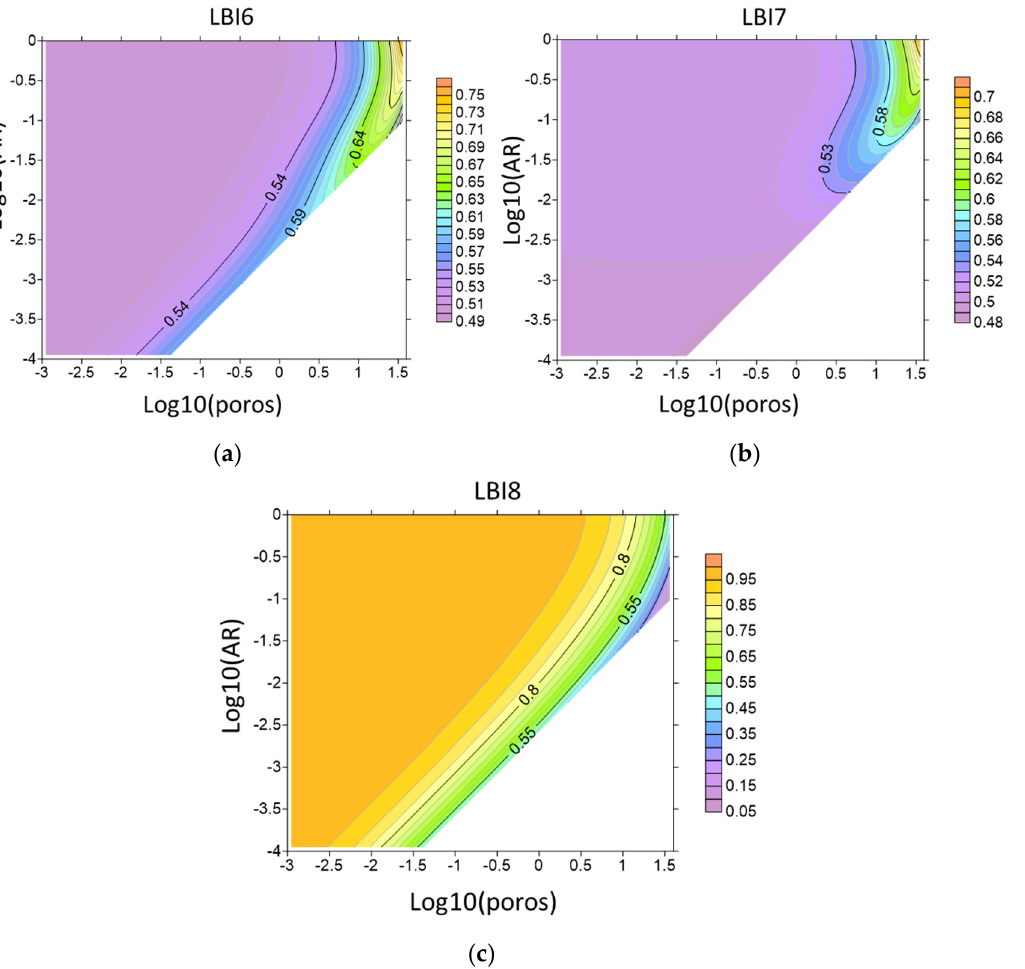
Figure 9. Brittleness indices ( a ) LBI 6 , ( b ) LBI 7 , and ( c ) LBI 8 for a model of carbonate matrix with randomly oriented brine-saturated voids versus decimal logarithms of porosity and void’s aspect ratio.